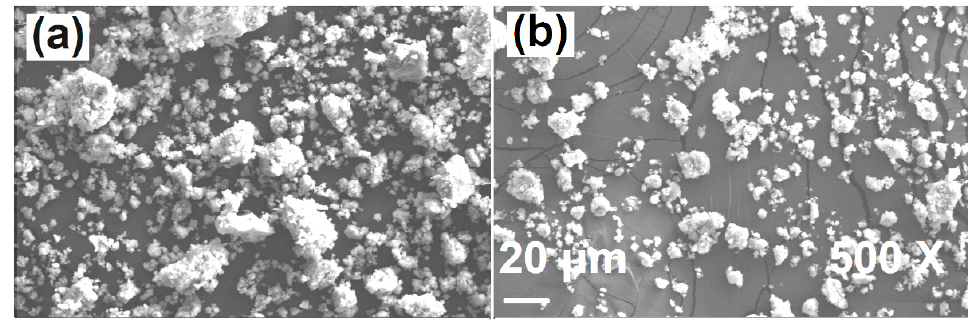
Figure 2. SEM micrographs of Mg65–Zn30–Ca5 milled for ( a ) 15 and ( b ) 20 h. Reprinted from Ref. [25]. Physics SRL, 2021.